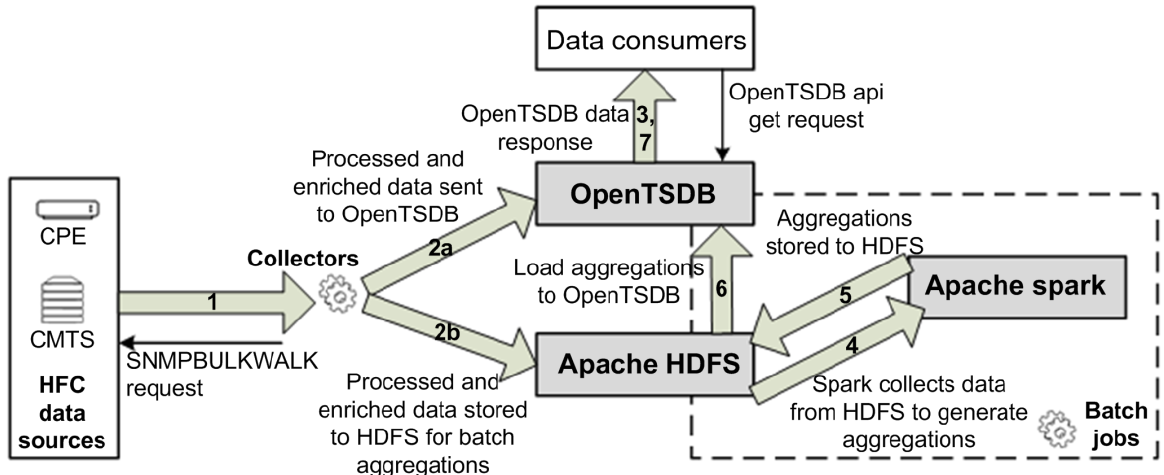
Figure 3. Collected-data flow through BDPfPM architecture.